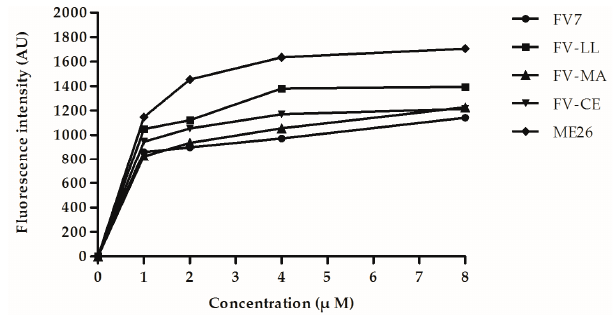
Figure 4. The outer membrane permeability of the parental and hybrid peptides.